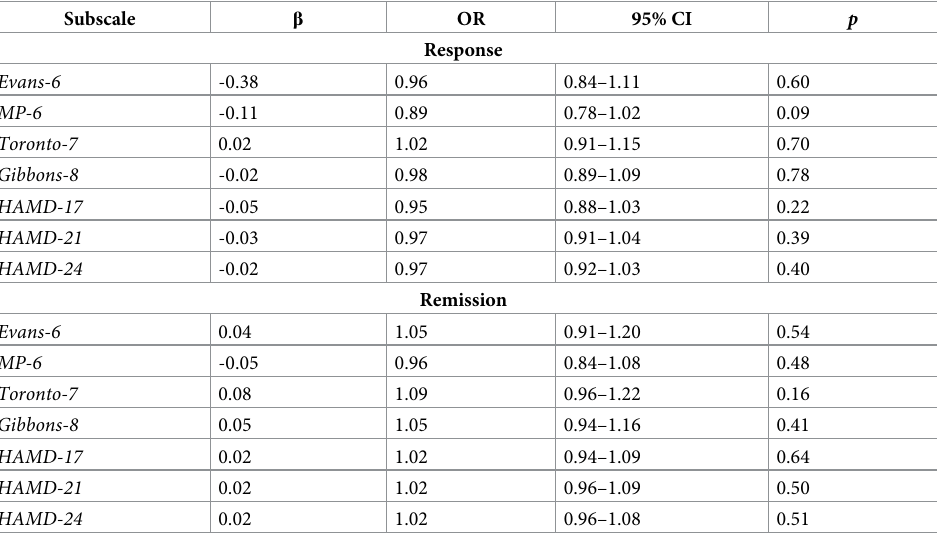
Table 4. Baseline HAMD subscales and full versions as predictors of response and